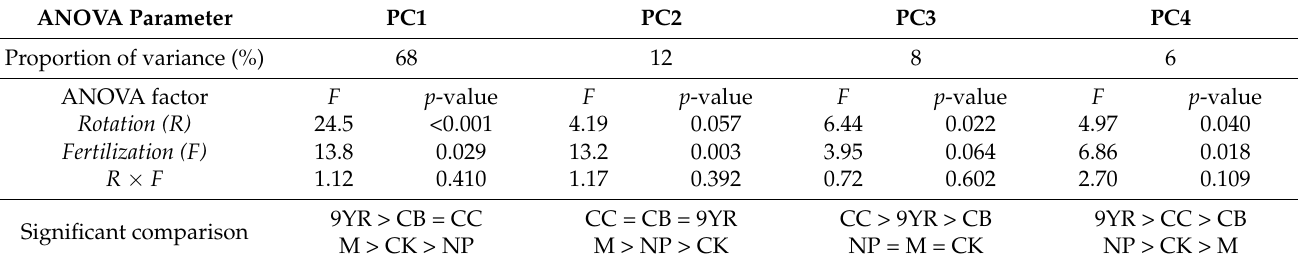
Table 4. Analysis of variance of results from the principal component analysis (PCA) (Figure 4) with respect to crop rotation and fertilization. Significant comparisons are in bold. ANOVA